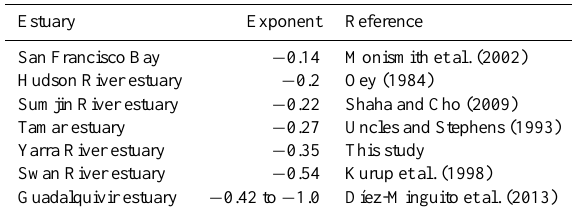
Table 3. Comparison of power-law exponents for different